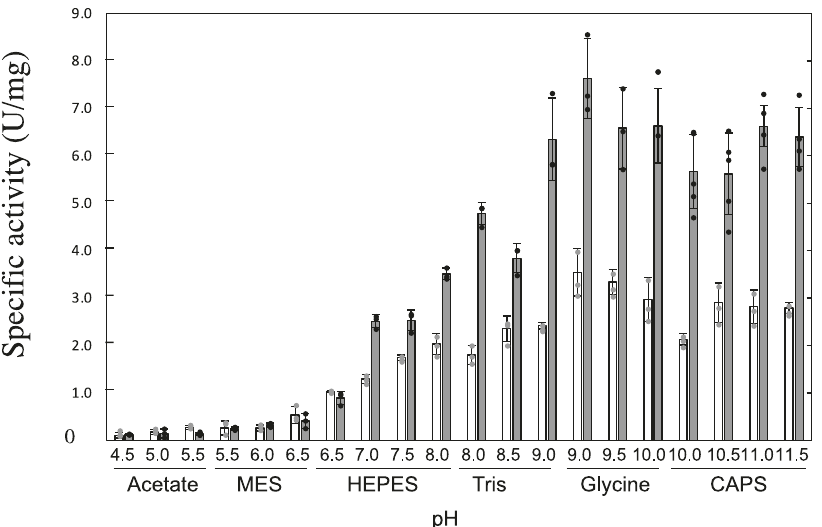
Fig. 2 Effect of pH on enzyme activity. The activity of the immature (white bar) and mature enzymes (gray bar) were assayed in 100 mM acetate (pHs 4.5, 5,0 and 5.5), MES (pHs 5.5, 6.0 and 6.5), HEPES (pHs 6.5, 7.0, 7.5 and 8.0), Tris (pHs 8.0, 8.5 and 9.0), Glycine (pHs 9.0, 9.5 and 10.0) or CAPS (pHs 10.0, 10.5, 11.0 and 11.5) at 303 K. The length of the error bars represents the standard deviation.